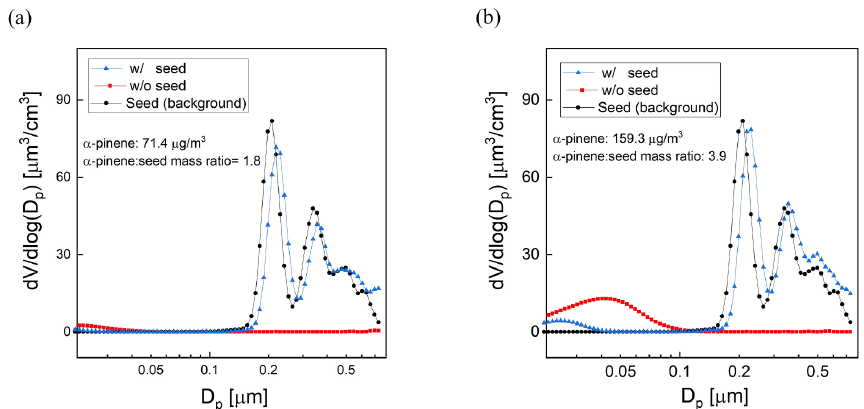
Figure 10. Example sets of volume size distributions from experiments evaluating the impact of adding AS seed particles on SOA yield. The precursor : seed mass ratio is (a) 1.8 (b) 3.9.